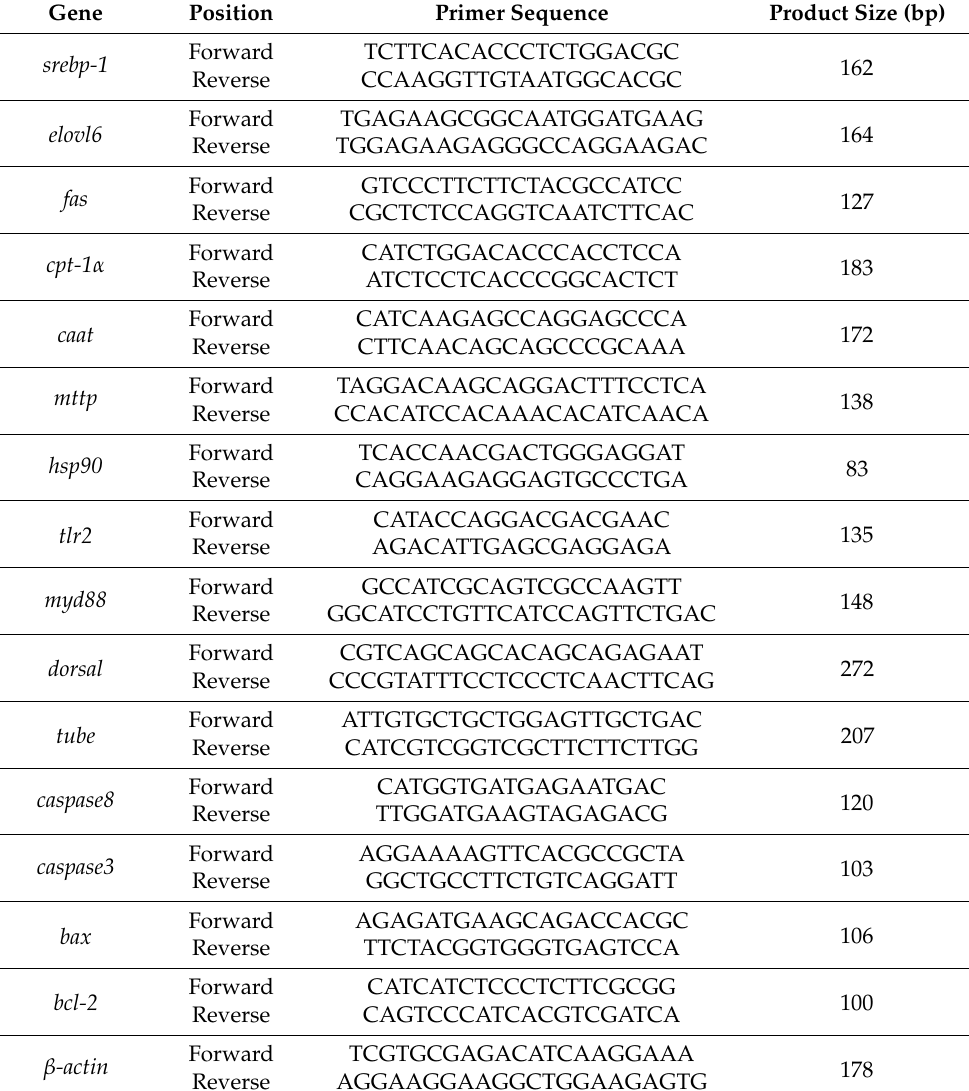
Table 3. Primer pair sequences for quantitative real-time PCR in this